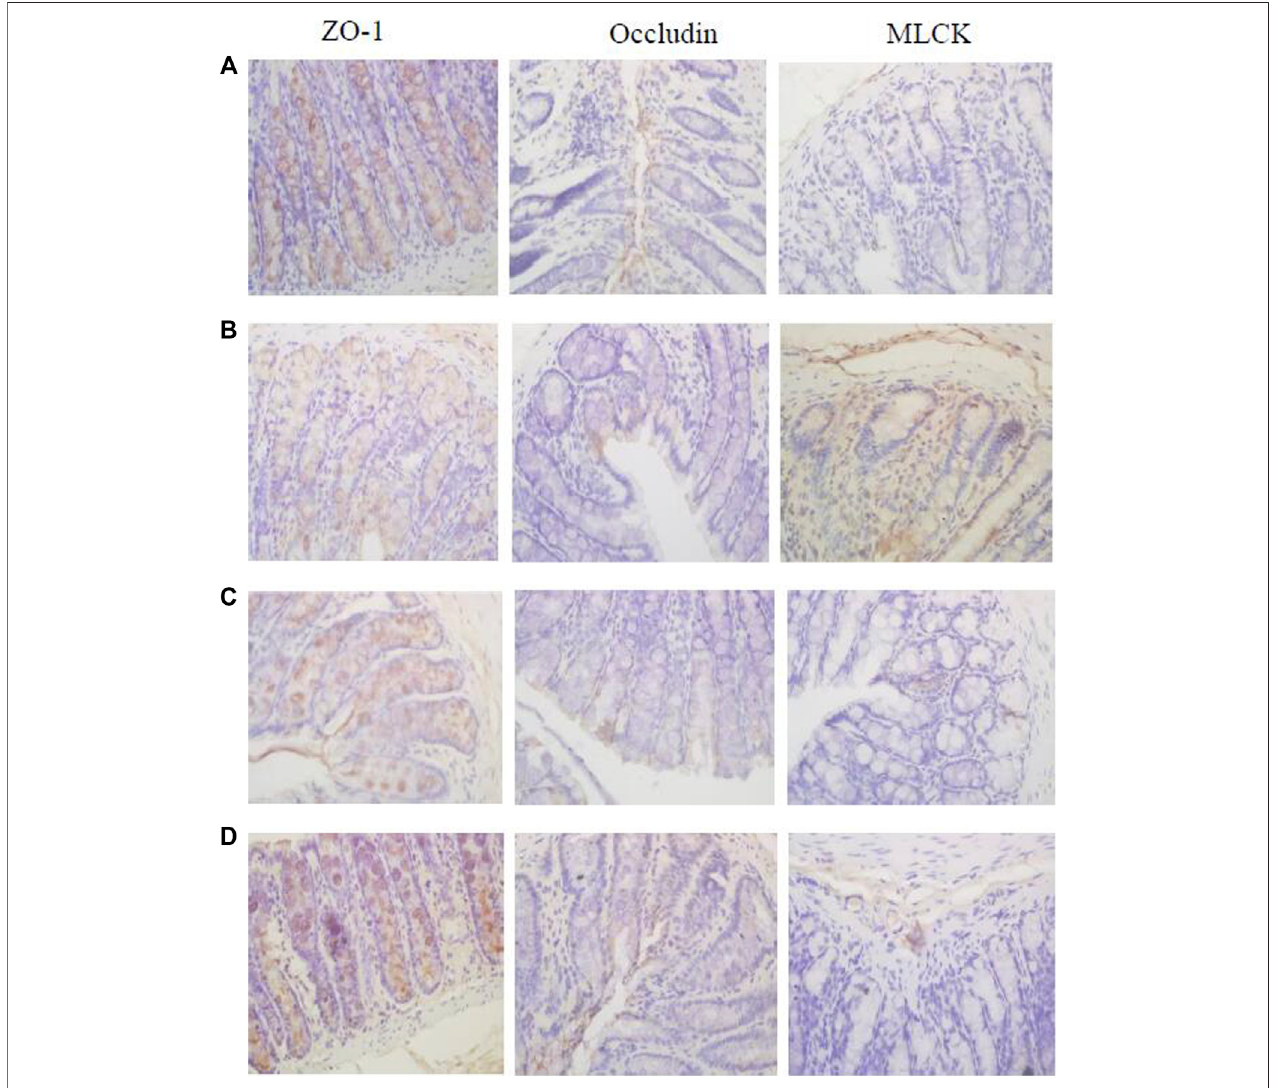
FIGURE6| TheexpressionofZO-1,Occludin,andMLCKintheratscolon[ (A) :normal; (B) model; (C) multipledoseofWJWinnormal; (D) multipledoseofWJWin model].